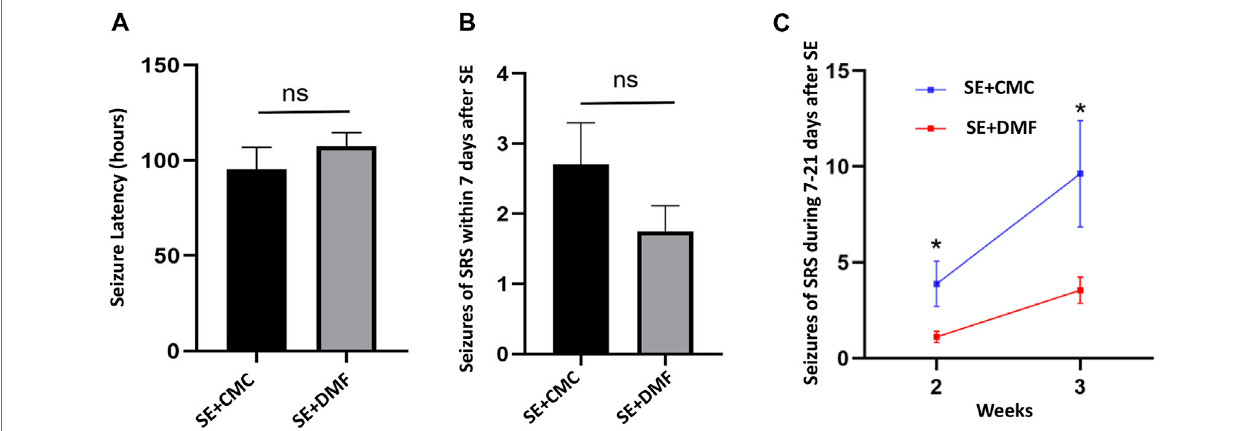
FIGURE 5 | DMF intervention attenuated SRSs from 7 to 21 days after kainic acid-induced SE. (A) Signi fi cant differences were not observed in the latency of the fi rstSRSwithin7 daysafterSEbetweenthetwogroups ( n (cid:1) 10intheSE+CMCgroup,n (cid:1) 8intheSE+DMFgroup). (B) Signi fi cantdifferenceswerenotobservedinthe numberofSRSswithin7 daysafterSEbetweenthetwogroups ( n (cid:1) 10intheSE+CMCgroup,n (cid:1) 8intheSE+DMFgroup). (C) NumberofSRSswithin7 – 14 daysand 14 – 21 days post-SE signi fi cantly decreased in the SE + DMF group ( n (cid:1) 8 in the SE + CMC group, n (cid:1) 9 in the SE + DMF